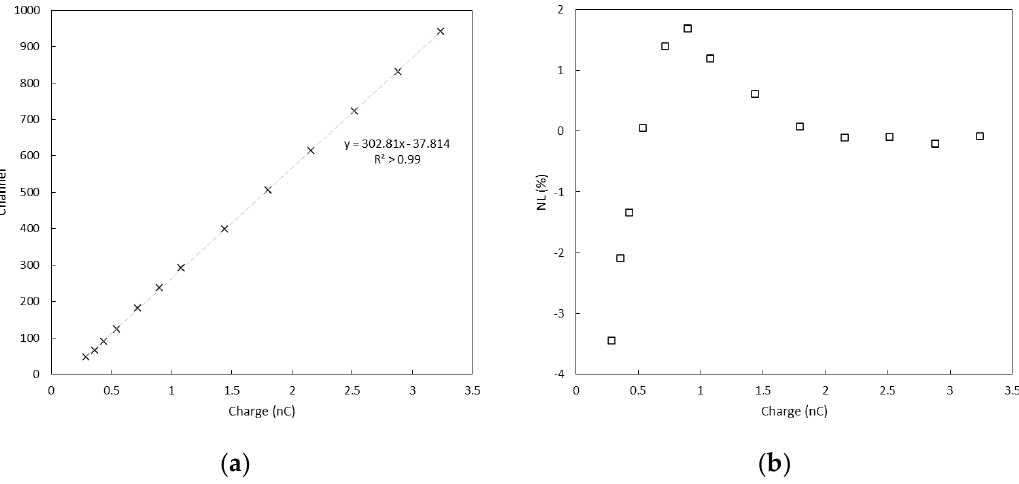
Figure 8. Results of charge calibration using a linear fit ( a ); relative residuals of the linear fit. The system shows less than 4% non-linearity through the dynamic range ( b ).